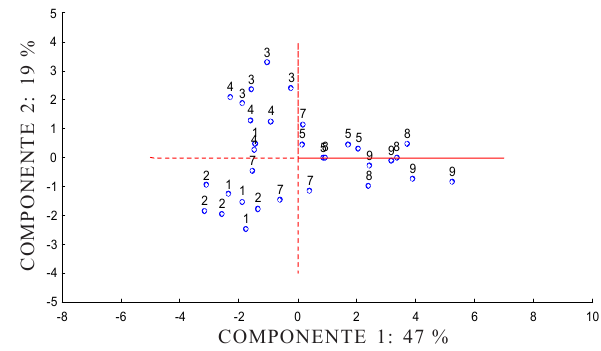
Figura 5. Projeção dos dois componentes principais retidos na análise dos onze nutrientes nas folhas dos eucaliptos, com as variações explicadas por cada componente. Os números sobre as observações identificam o